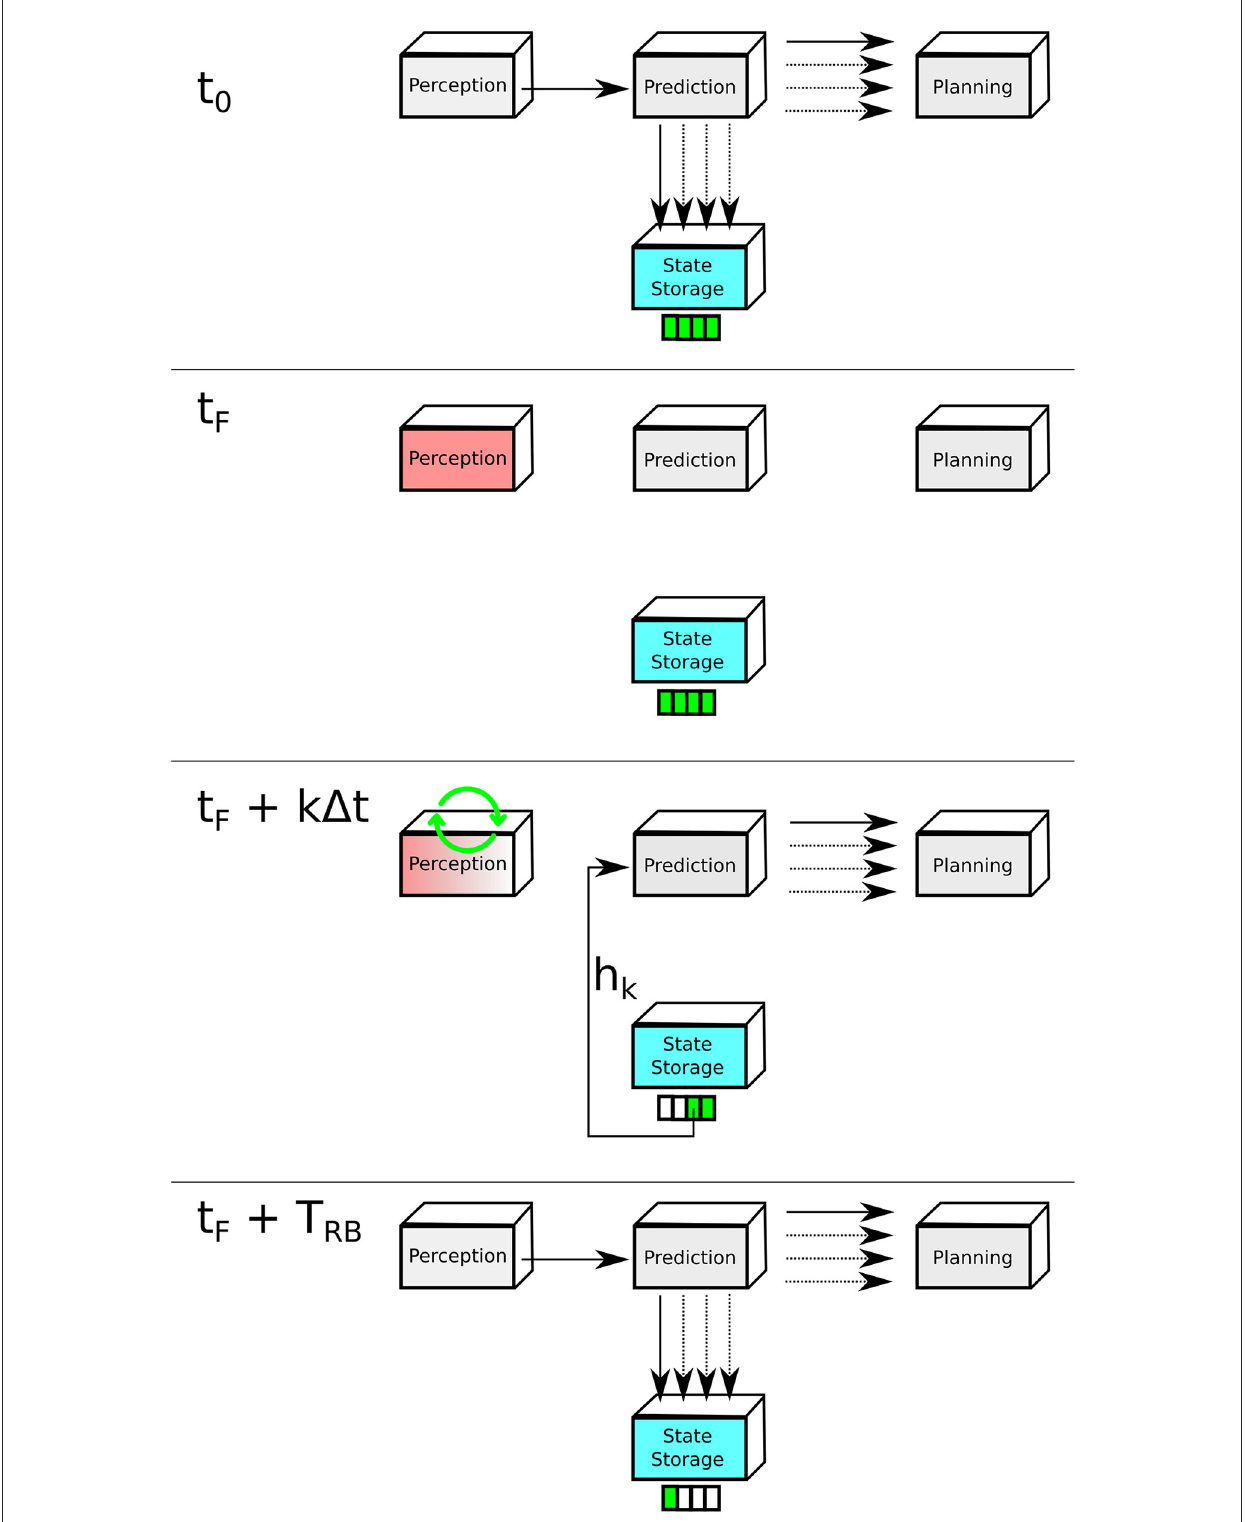
FIGURE3 Perception module recovery. Parameters t F and T RB denote the onset of the reboot and reboot time of the prediction module, respectively. h k is the stored state corresponding to the future time instance k and 1 t is the sampling period of the prediction module